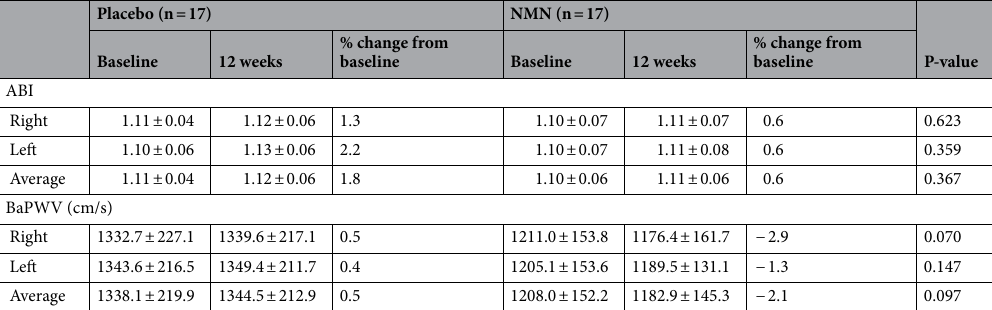
Table 4. Parameters for assessing the vascular function of the placebo and NMN intake groups before and after the intervention period. Values are presented as mean ± standard deviation. Primary efficacy variables were statistically analyzed using a full-analysis-set population. Analysis of covariance (ANCOVA) was applied for significance between the two groups using the baseline as a covariate. Statistical significance was set at p < 0.05. ABI ankle-brachial index, baPWV brachial-ankle pulse wave velocity, NMN nicotinamide mononucleotide.